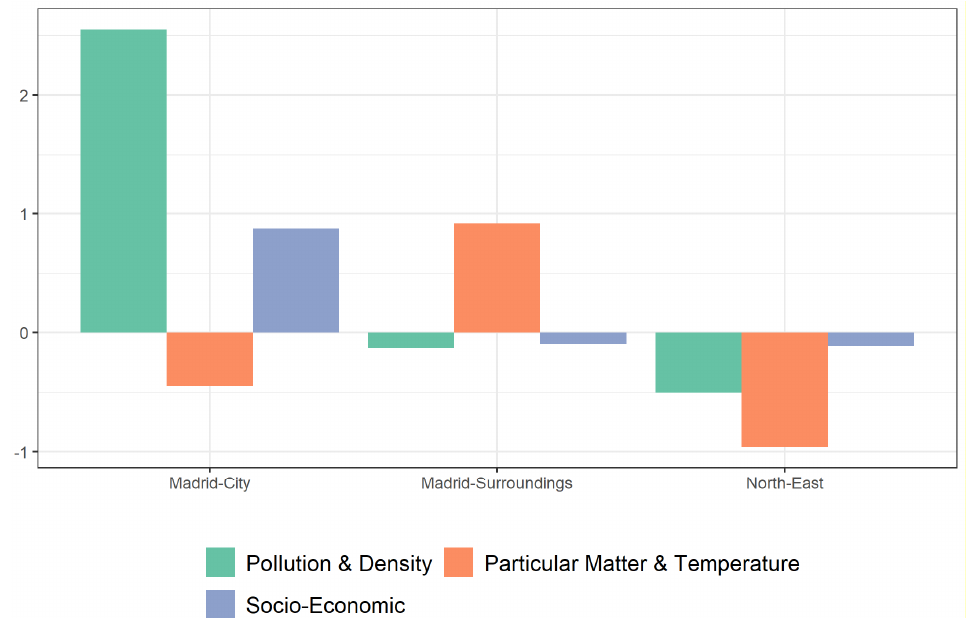
Figure 1. Cluster with components.